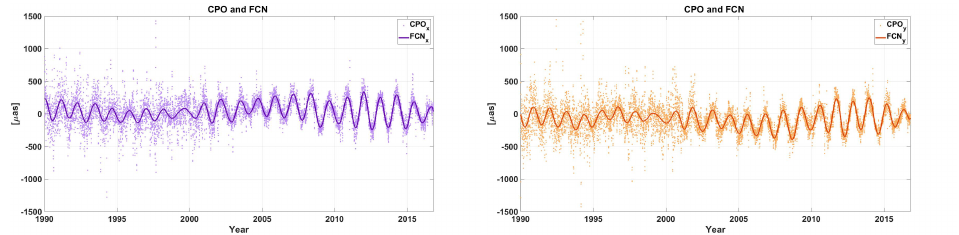
Figure 3. CPOs (dots) and FCN model B 16 (line) in X (purple) and Y (orange) direction.